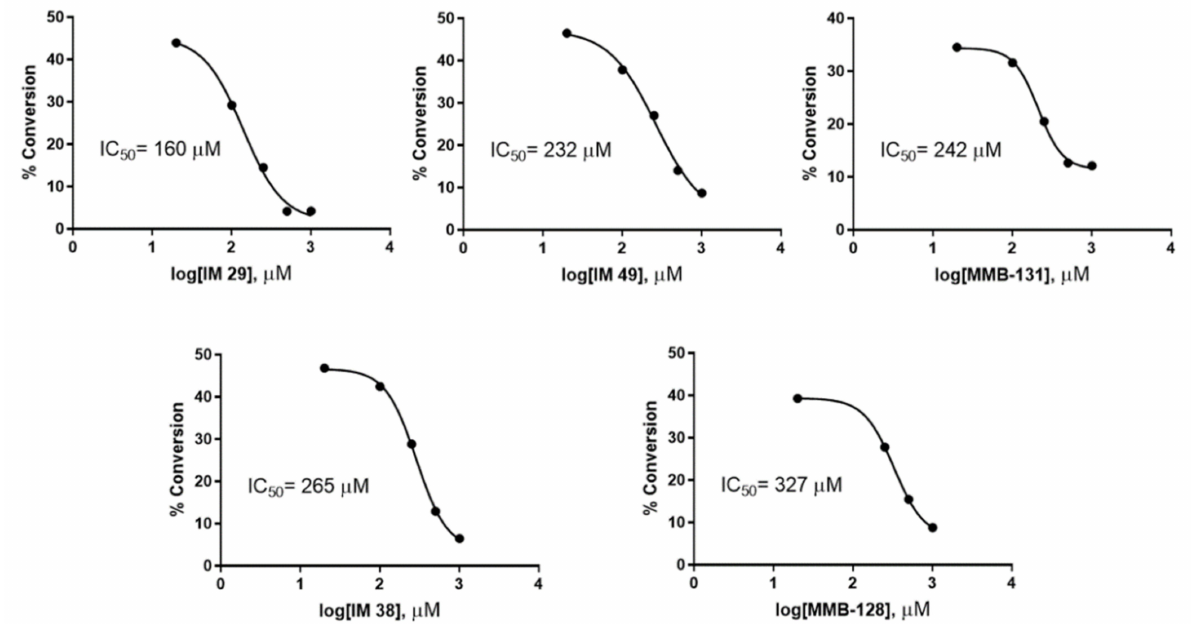
Figure 4. Compounds IM 29, IM 49, MMB-131, IM 38, and MMB-128 inhibit recombinant hNAPRT in the µ M range. The test compounds were added at different concentrations to reaction mixtures containing hNAPRT and substrates and the half maximal inhibitory concentration (IC 50 ) was obtained for each compound by measuring the amounts of NA and NAMN that was present after the